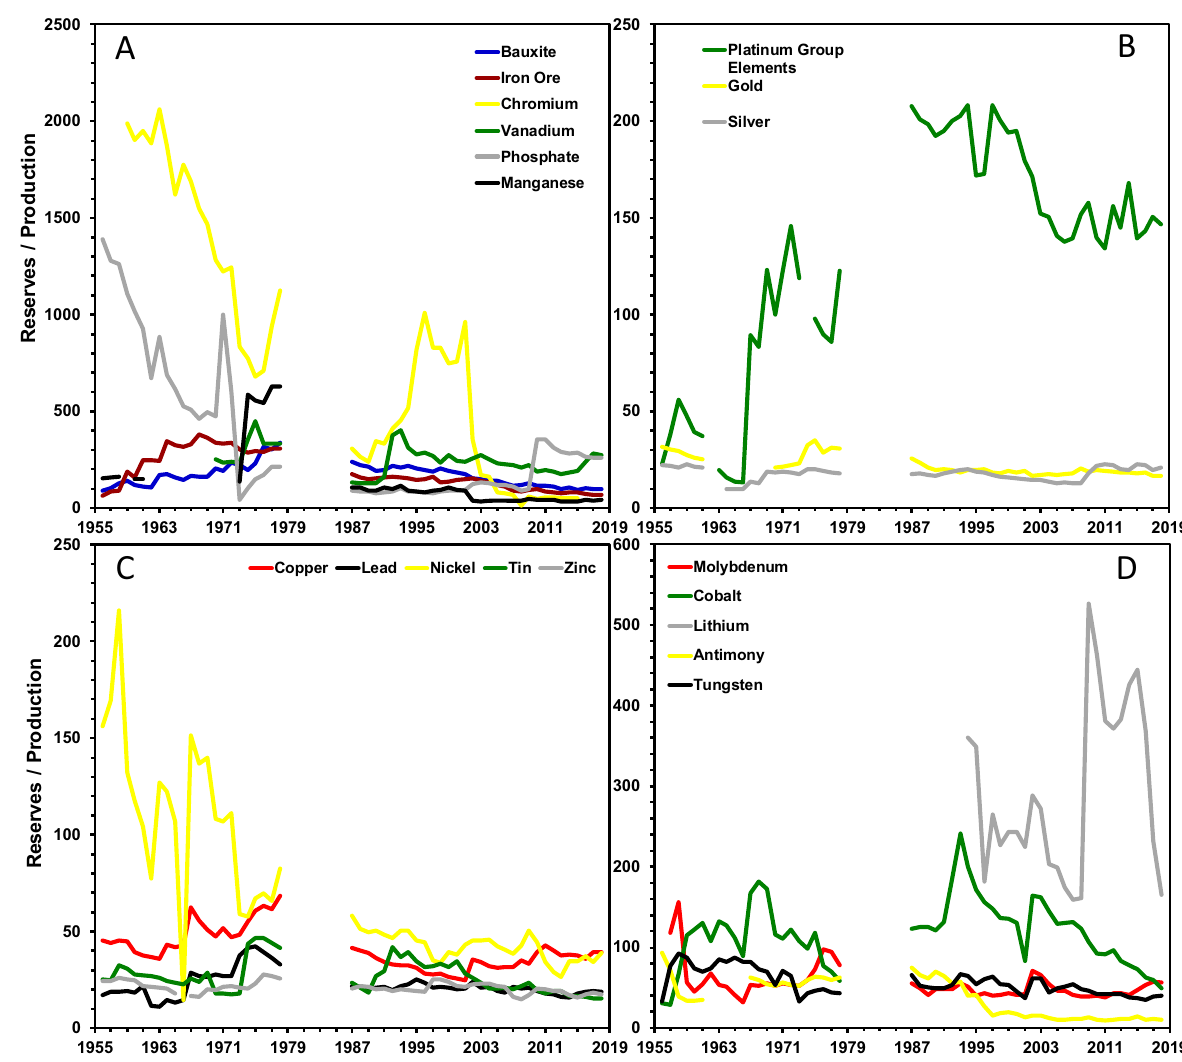
Fig. 2 Annual metal production and reserve data for 1956 – 2018 27 – 29 . Data are shown as reserve/production ratio for selected bulk and ferrous minerals ( a ), precious ( b ), base ( c ) and minor ( d ) metals. Note the data gap (1979 – 1986) when only “ reserves base ” estimates were published, which are effectively the same as